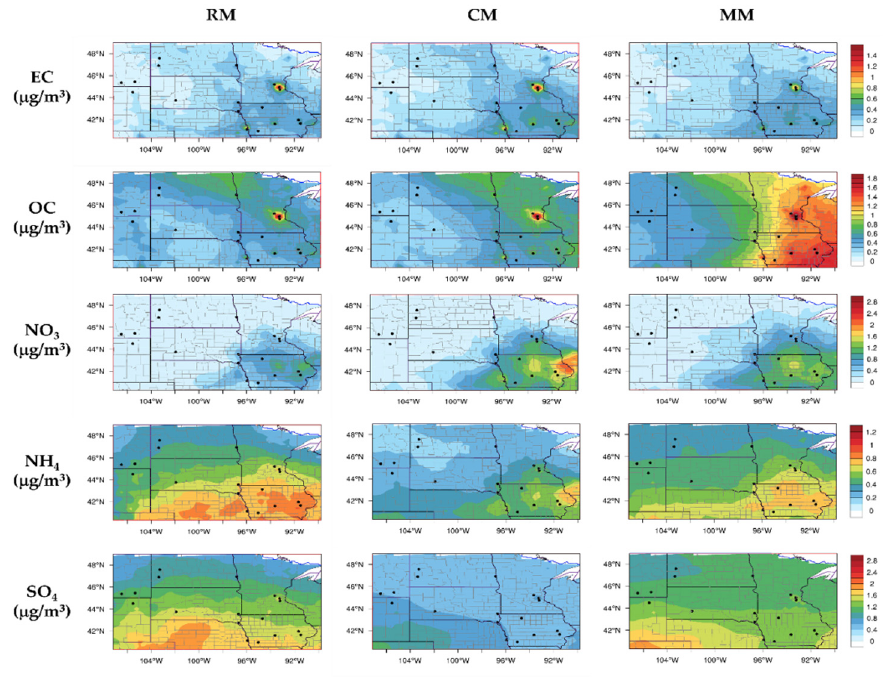
Figure 10. Monthly average of predicted hourly PM2.5 subspecies concentrations ( μ g/m 3 ) during July 2010 for RACM-MADE/SORGAM (RM), CBMZ-MOSAIC (CM), and MOZART-MOSAIC (MM) mechanisms. Table 7. Statistical analysis of predicted daily average PM2.5 subspecies concentrations for the RACM-MADE/SORGAM (RM), CBMZ-MOSAIC (CM), and MOZART-MOSAIC (MM) chemistry- aerosol mechanisms. Comparison is carried out with daily average observation data collected every third